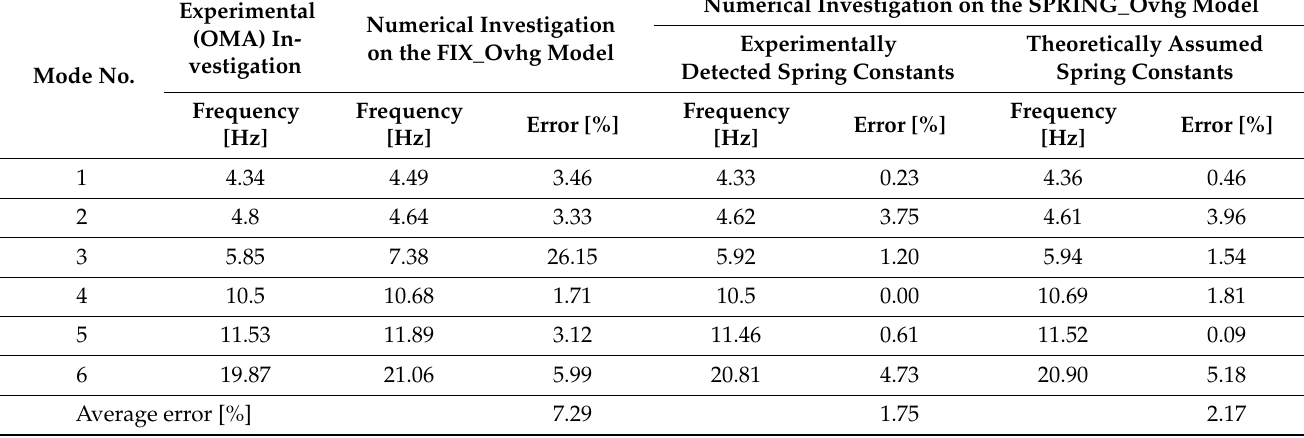
Table 5. Natural frequencies: theoretical and numerical vs. experimental values for the FIX_Ovhg and SPRING_Ovhg models of the footbridge.